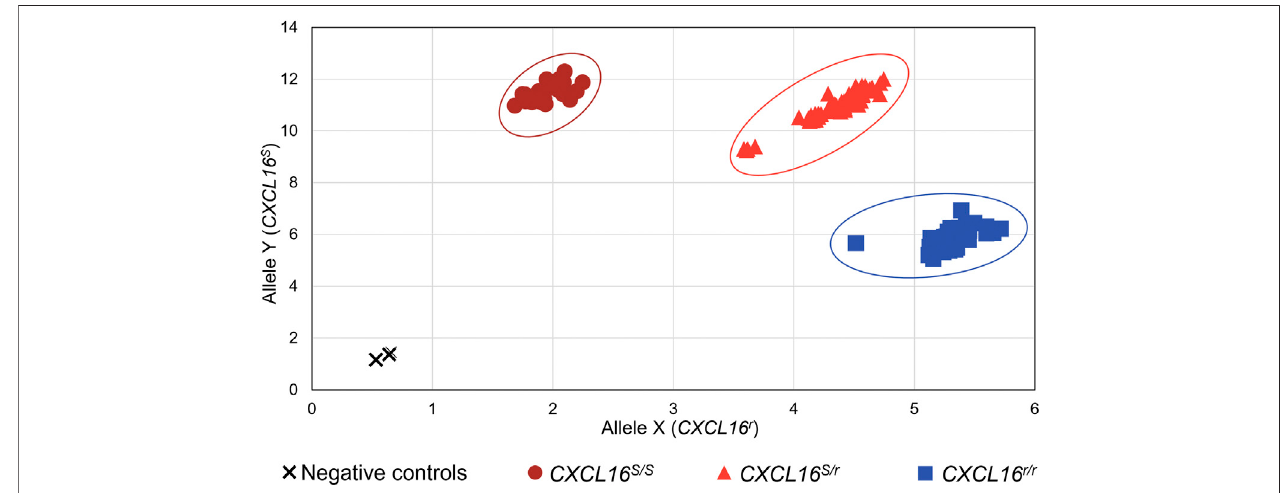
FIGURE 3 | Equine CXCL16 allelic discrimination assay output and allele determination. The TaqMan ® allelic discrimination qPCR assay was used for genotyping CXCL16 S and CXCL16 r alleles of 160 horses. The X-axis represents the fl uorescence intensity for the CXCL16 r allele-speci fi c probe labeled with VIC. The Y-axis represents the fl uorescence intensity for the CXCL16 S allele-speci fi c probe labeled with FAM. Dark red circles: homozygous CXCL16 S/S ( n = 30); light red triangles: heterozygous CXCL16 S/r ( n = 74); blue squares, homozygous CXCL16 r / r ( n = 56); black cross; negative controls (no DNA). The negatives controls, without gDNA, were located in the bottom left of the graph and were distinct from the positive